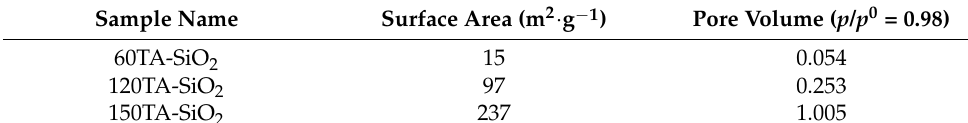
Figure 5. N 2 adsorption/desorption isotherms at − 196 °C of: 60TA-SiO 2 , 120TA-SiO 2 and 150TA-SiO 2 NPs. Adsorption and desorption branches were indicated with filled and empty symbols, respectively. Table 3. Textural properties of 60TA-SiO 2 , 120TA-SiO 2 and 150TA-SiO 2 NPs.